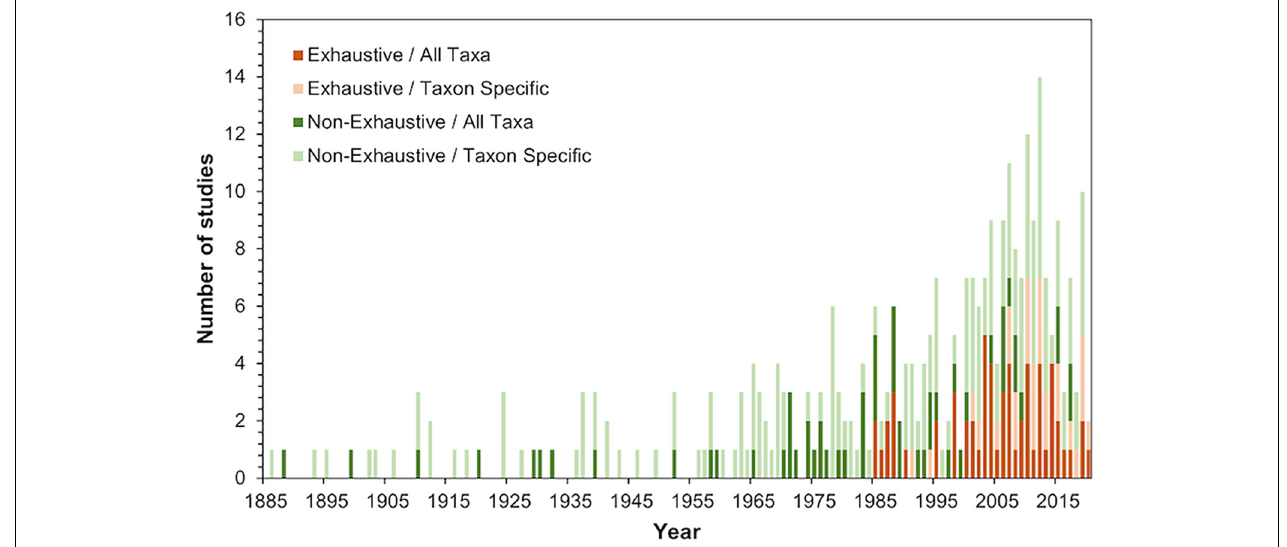
FIGURE 1 | Number of All Taxa, Taxon Specific, Exhaustive, and Non-Exhaustive studies by year that included data on sea turtle-epibiont interactions identified during our two-tiered search of both published scientific articles and gray literature (e.g., government reports, theses and dissertations, and conference presentations). All Taxa studies attempt to document all possible epibiont taxa, while Taxon Specific studies focus on one or more specific taxonomic groups. Exhaustive studies sampled all observed epibionts, while Non-Exhaustive only sampled a subset of the observed